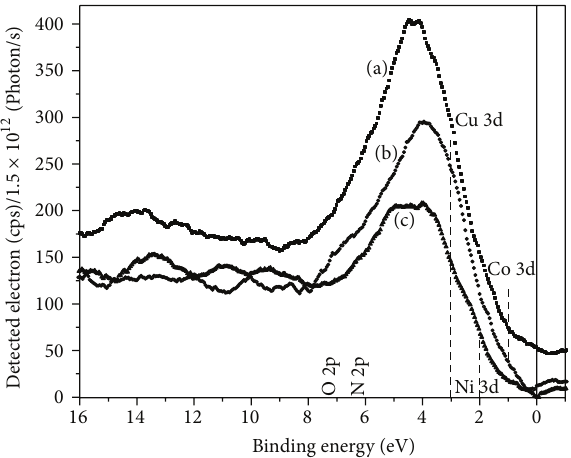
Figure 6: XPS valence band spectra of (a) [Cu 3 ( S,S (+)cpse) 3 ⋅ (H 2 O) 3 ] ⋅ 8H 2 O, (b) [Cu 2 Co( S,S (+)cpse) 3 (H 2 O) 3 ] ⋅ 4H 2 O ( 1 ), and (c)